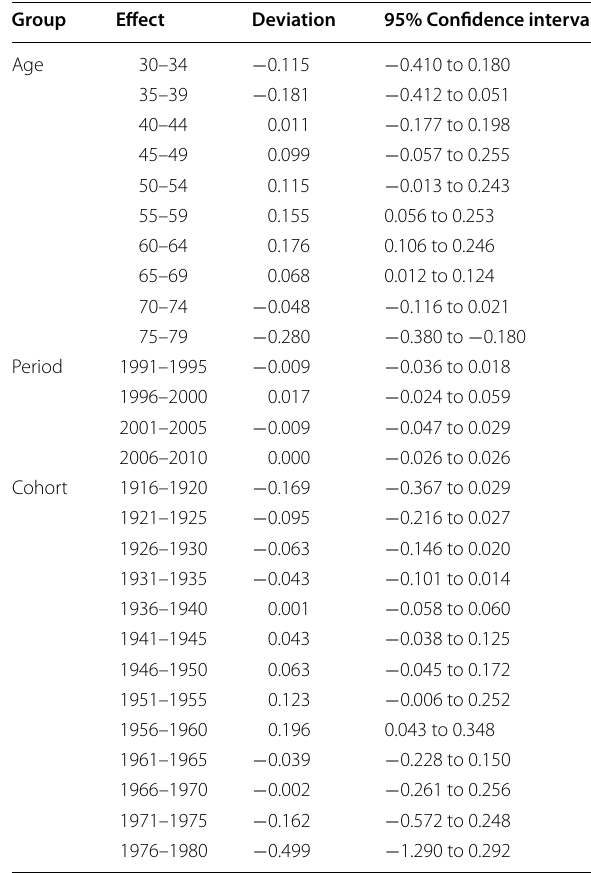
Table 3 Age, period, and cohort effects on colorectal can- cer mortality in Serbia during 1991–2010 Group